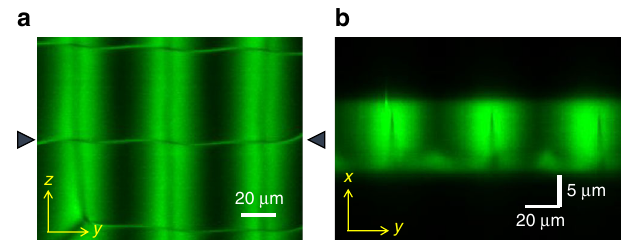
Fig. 6 Confocal fl uorescent microscopy of the square web of twist disclinations in the surface patterned nematic LC cell. An anisotropic fl uorescent dye was mixed in the LC. a Top view ( y – z plane) of the cell under a linearly polarized excitation. The disclinations are captured as the thin horizontal lines and the dark lines inside the broad bright bands . b Cross- sectional view ( x – y plane at the center of the cell) along the horizontal disclination line at the center (indicated by solid triangles in a ). The vertical disclination line is located at the tip of the vertical dark shadow inside the bright band, and the bright structure running at the lower boundary indicates the horizontal line . The spacing between the vertical and horizontal lines is ca. 5 μ